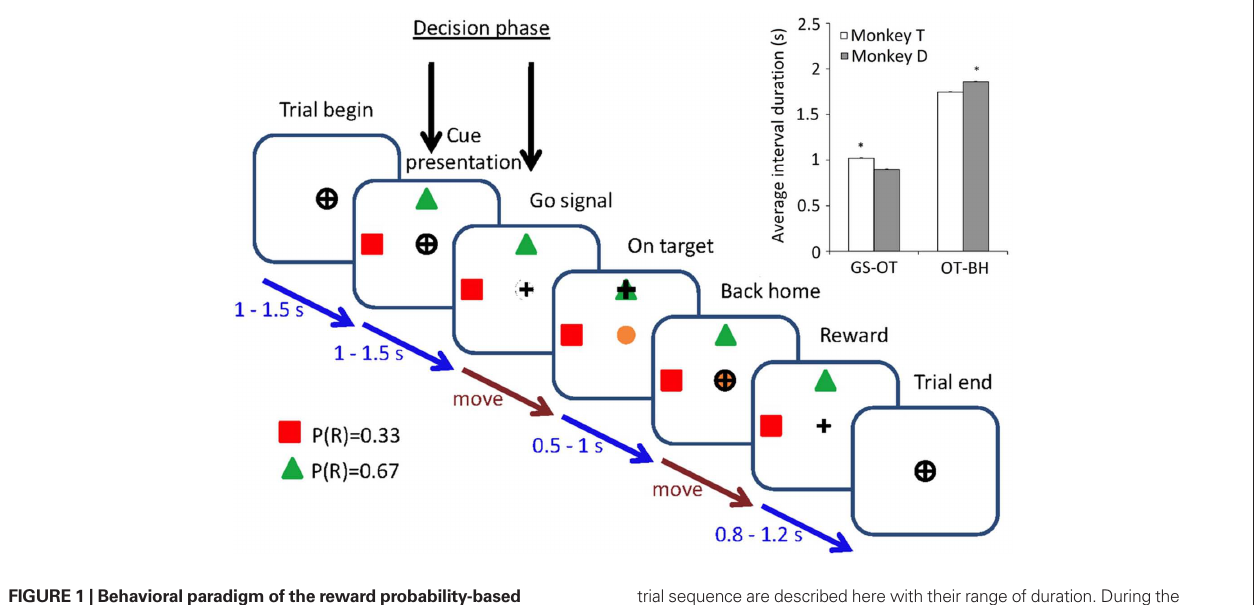
Figure 1 | Behavioral paradigm of the reward probability-based free-choice task. Two different targets associated with reward probabilities (here P (R) = 0.33 and 0.67) are displayed simultaneously during each trial in four possible positions in random order (six target combinations) and in random locations (4 × 3 possibilities). The different milestones of a